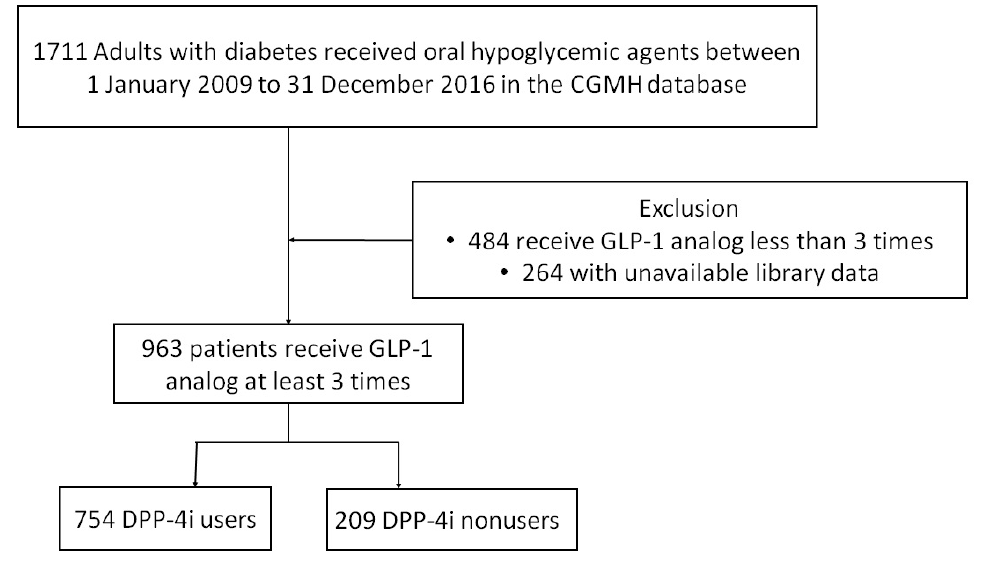
Figure 1. Flow diagram for selecting study patients. The study participants selected from CGRD records from 1 January 2009 to 31 December 2016 were screened using inclusion and exclusion criteria. A total of 963 patients were identified for the final analysis.